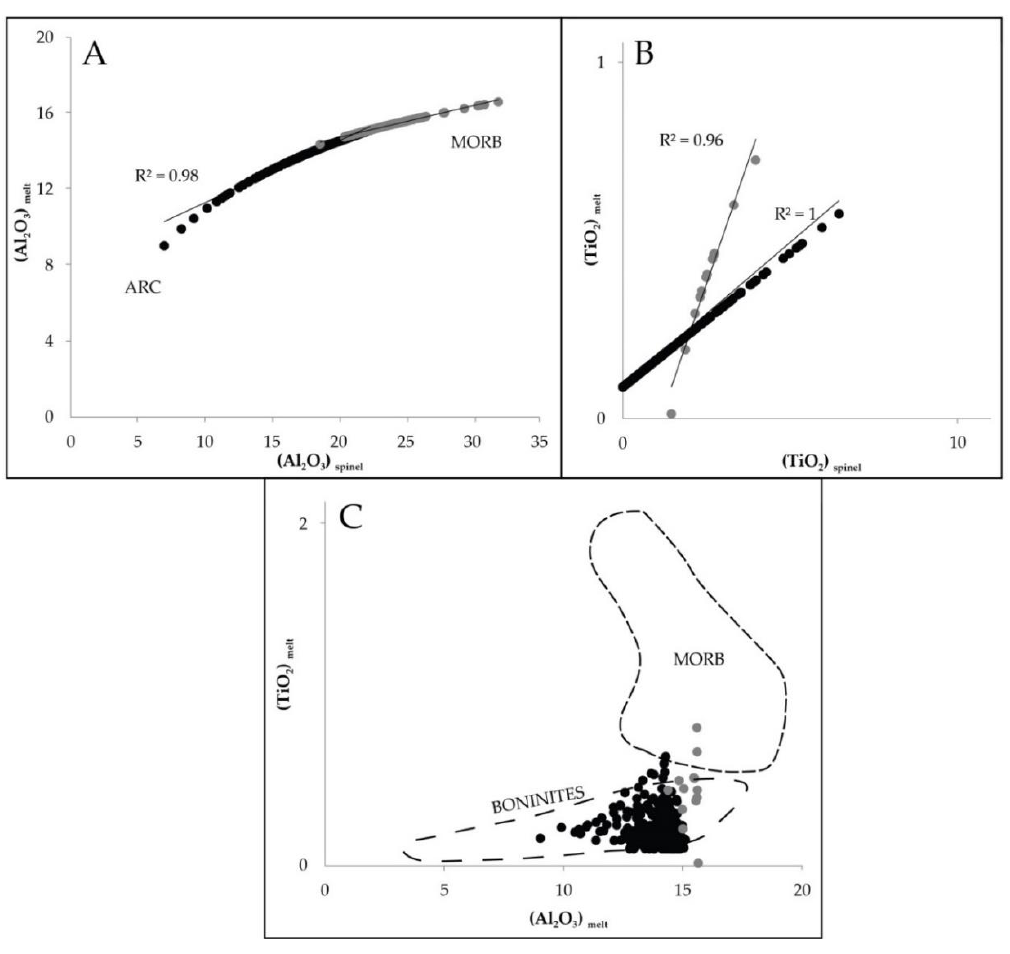
Figure 10. ( A ) Al 2 O 3 melt vs. Al 2 O 3 spinel , and ( B ) TiO 2 melt vs. TiO 2 spinel relationships after [44,45,52]; ( C ) the melt of TiO 2 melt vs. Al 2 O 3 melt was calculated as in equilibrium with chromite. Plot of analyzed samples from Jayapura. Fields for boninites and mid-ocean ridge basalt (MORB) after [55,56]. Black dots: high-Cr spinels, grey dots: high-Al spinels.